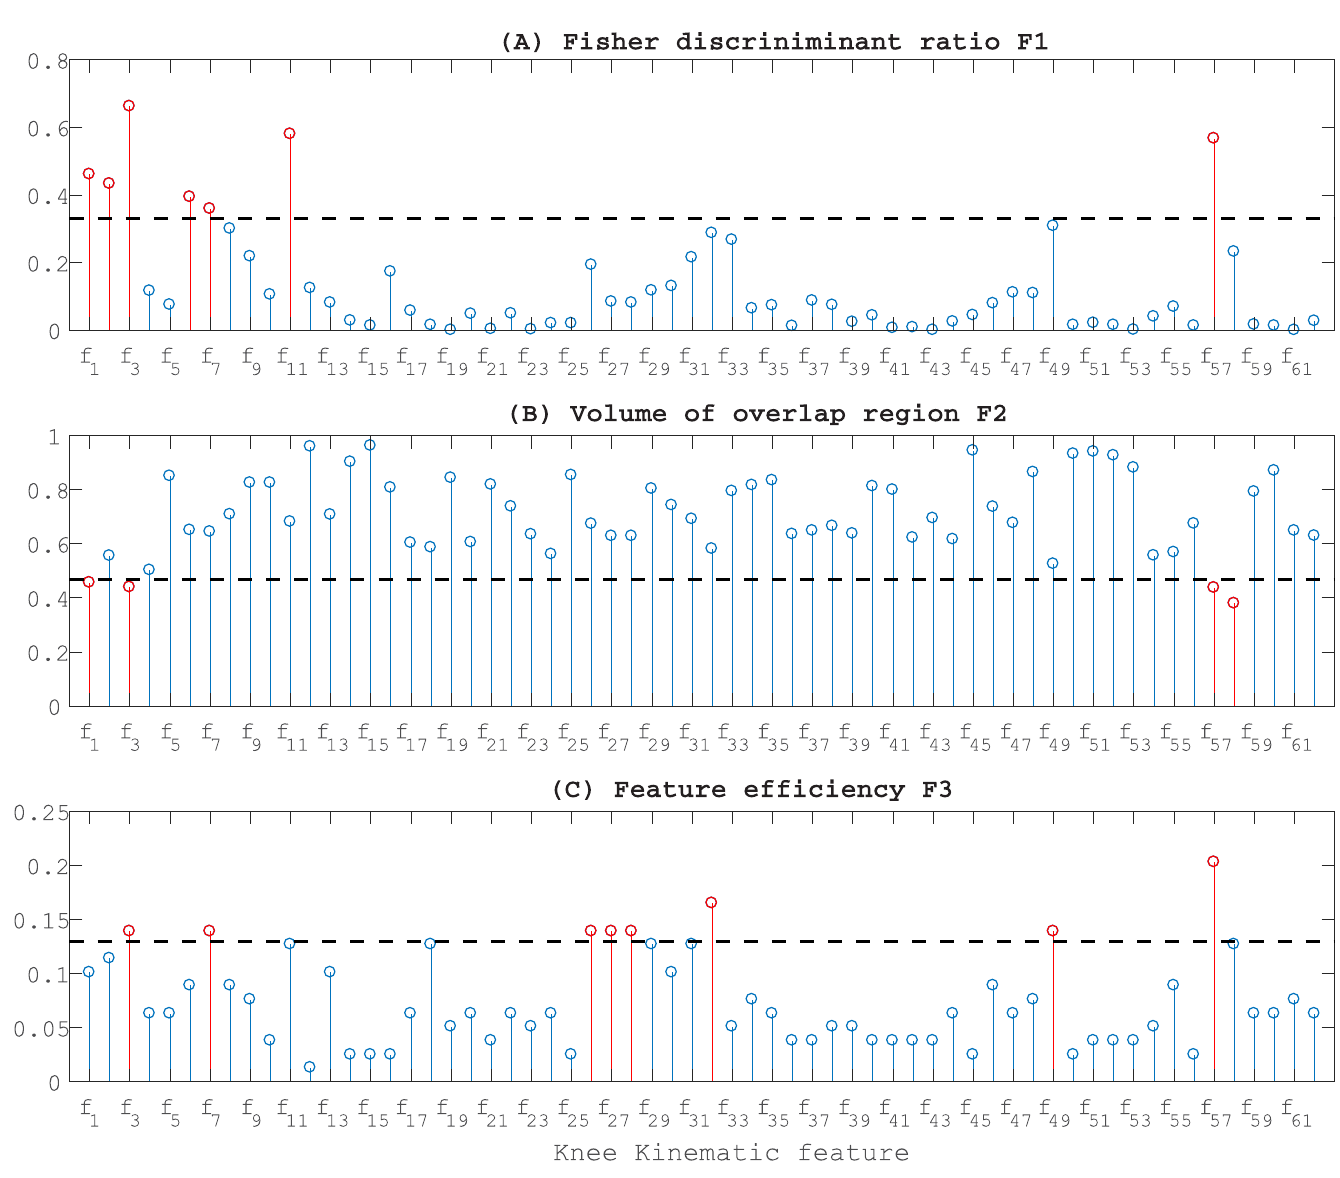
Fig 3. Measures of single feature complexity for feature f ( i = 1, 2, ... , 62): (A) The Fisher discriminant Ratio F1 i discriminant. (B) The ratio of the width of the overlap interval F1 i ; a low value of F2 i measure means that the feature can discriminate the samples of different classes. (C) The feature efficiency F3 ; a high value of F3 indicates a good efficiency. The horizontal dotted black lines correspond to the threshold values of each single feature i i complexity. The red vertical lines correspond to the retained discriminant features while the blue ones correspond to the features having high complexity.